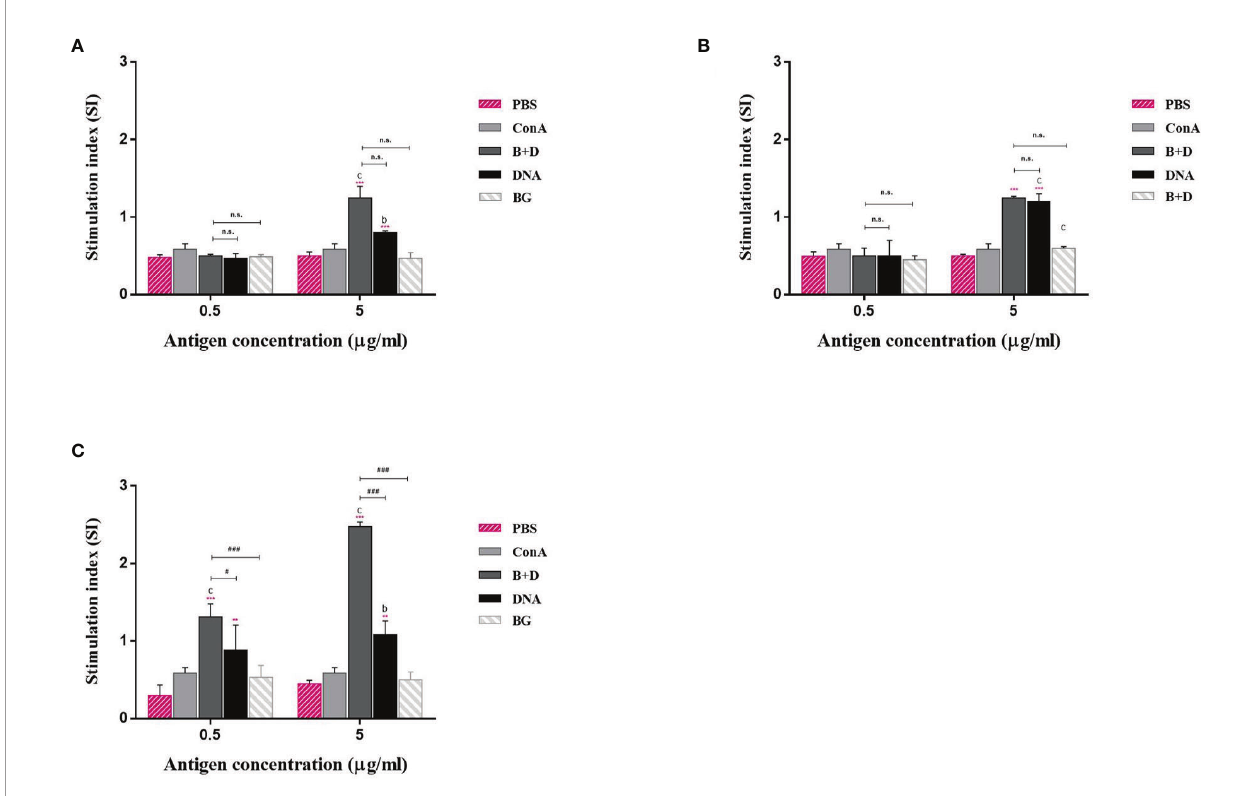
FIGURE 11 | Lymphoproliferation assay. Lymphocytes from the mice immunized by the (A) oral, (B) intramuscular, or (C) intraperitoneal route were prepared 14 days after the last immunization and cultured with VP6 protein of fi nal concentration of 0.5 or 5 m g/mL. The splenocytes stimulated with 5 m g/mL ConA as the positive control. The splenocytes untreated were used as negative controls. Values are expressed as the mean ± SD of fi ve individual experiments. Signi fi cance of differences between the PBS, ConA, BG+DNA, DNA, and bacterial ghost (BG) groups is represented as follows: *P < 0.05, **P < 0.01, ***P < 0.001. Letter indicates signi fi cant differences between ConA, BG+DNA, DNA, and BG groups: a P < 0.05, b P < 0.01, c P < 0.001. #Asterisk indicates signi fi cant difference between BG +DNA, DNA, and BG groups: # P < 0.05, ## P < 0.01, ### P <